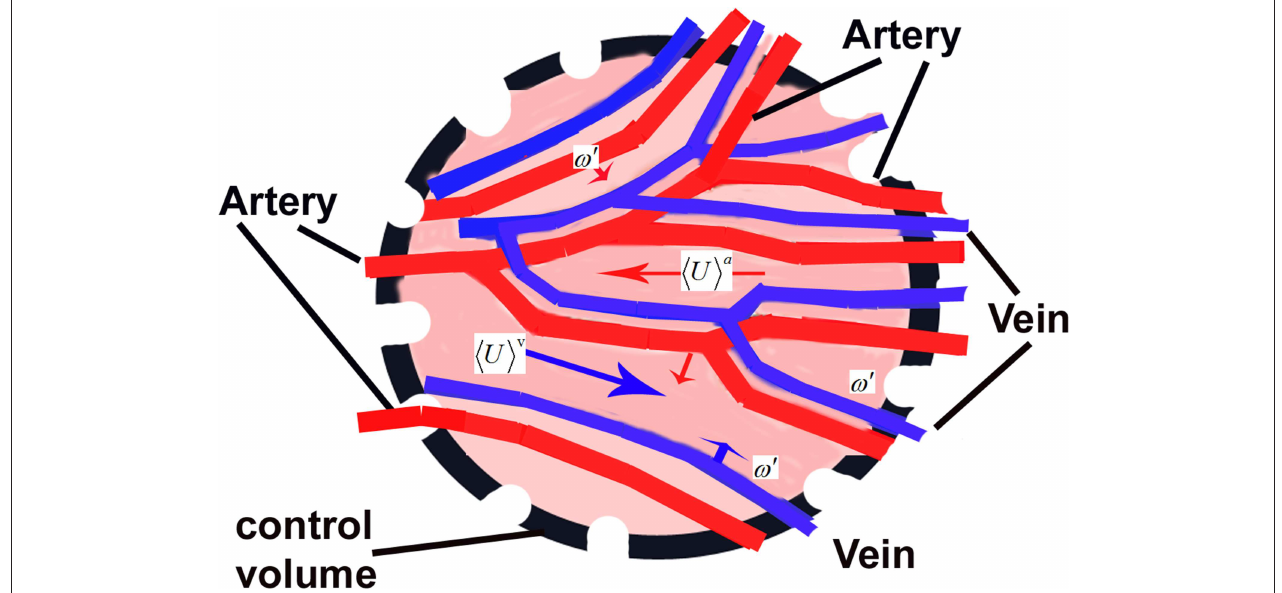
FIGURE 6 | A schematic presentation of a control volume V in a tissue with blood supply through arteries and veins in parallel relevant to the studies of porous media approach.